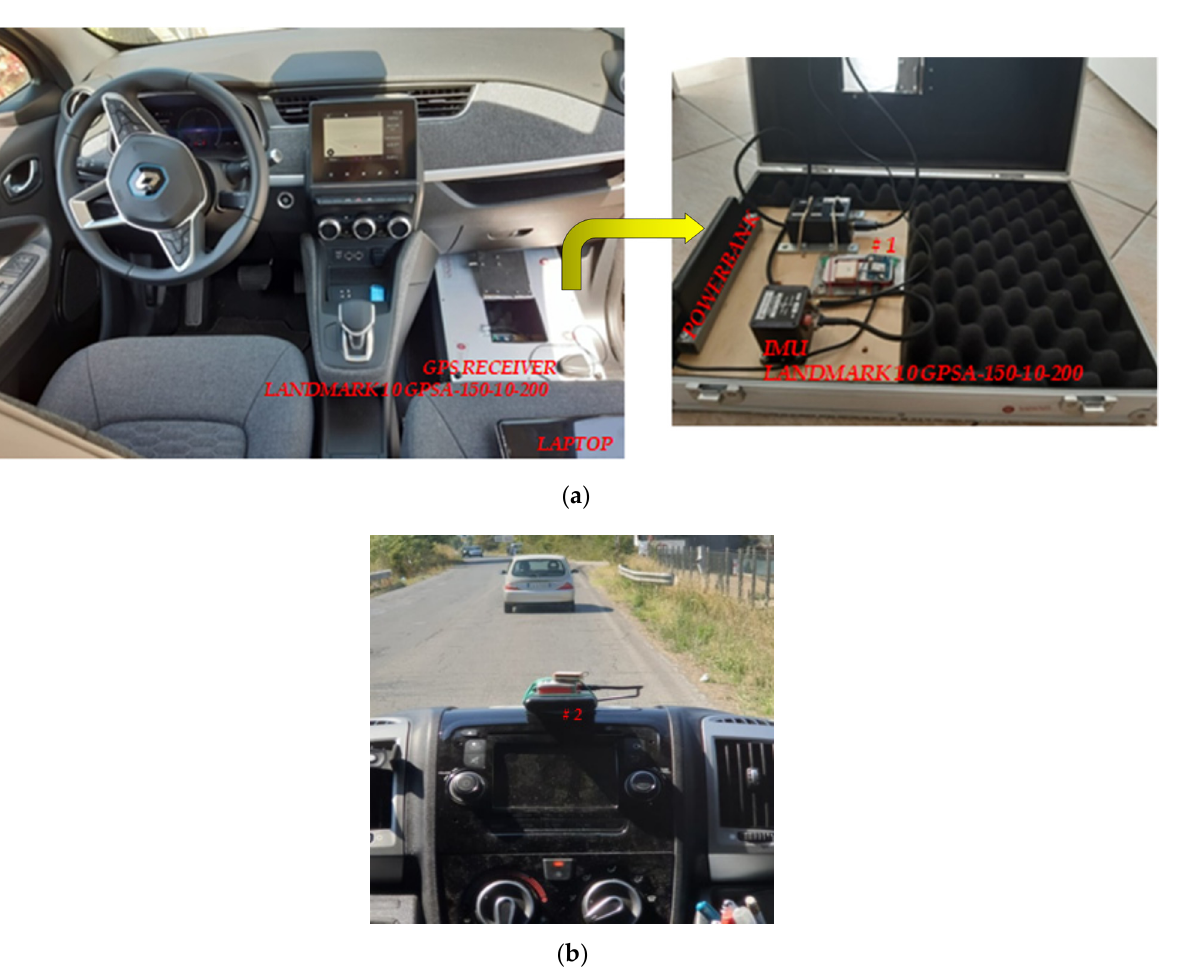
Figure 8. Position of the prototypes: ( a ) SENSOR#1 inside Renault Zoe; ( b ) SENSOR#2 inside Cartesio.